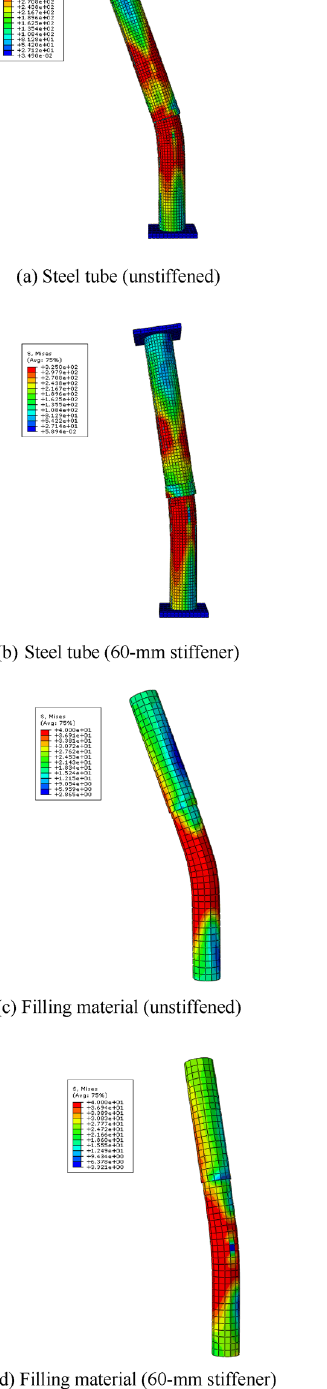
Fig. 16 Comparison of nephograms of axial compressive stress